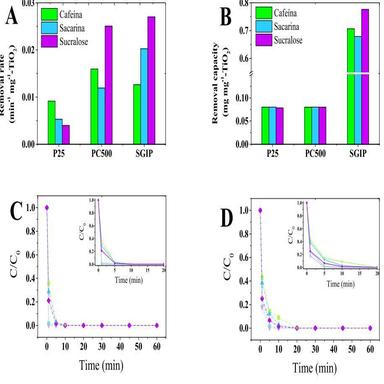
(A) Normalized values of the first-order model kinetic model (k, min− 1 )) and (B) removal capacity (mg mg− 1 ) by means of TiO2 mass for caffeine, saccharin, and sucralose removal by P25, PC500, and SGIP. Initial concentration of the contaminants = 2 mg L− 1 and photocatalyst = 25 mg L− 1 . Removal of the contaminants by the SGIP heterostructure under UV-C (8 W) irradiation in (B) ultrapure water and (C) reclaimed water. The inset graphs show a zoom-in of the first 20 min of the removal process. Initial co